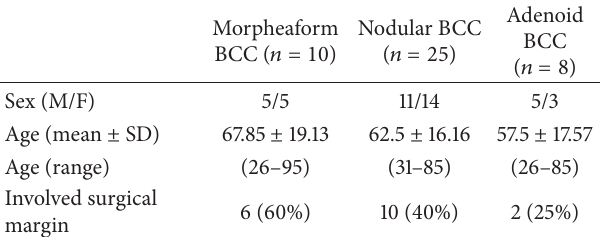
Table 1: Clinical and pathological data of different types of perioc- ular